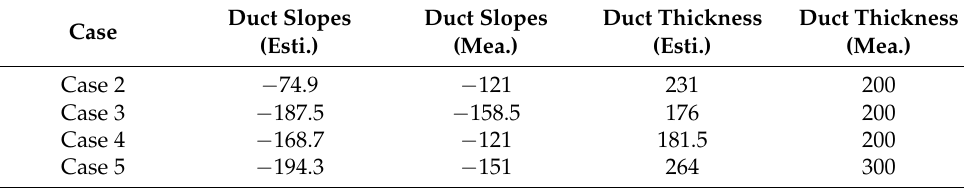
Table 2. Summary of all estimation